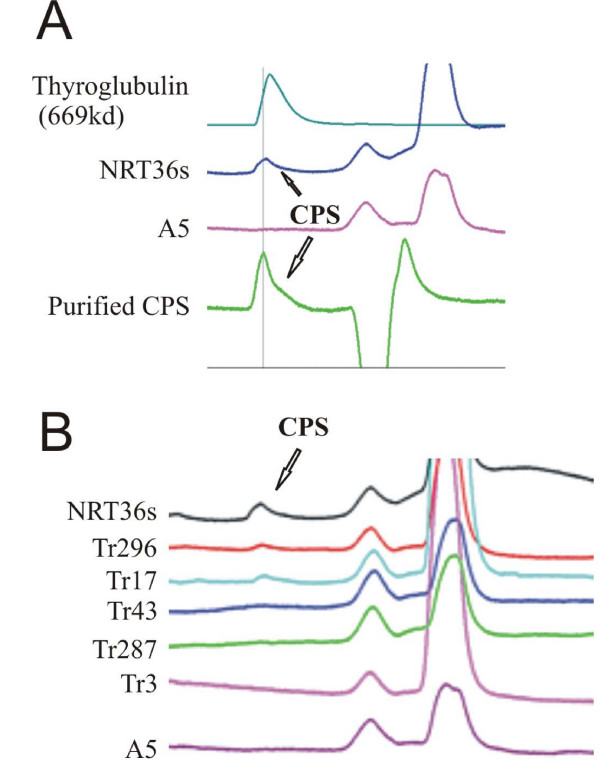
Size exclusion chromatography of the capsule prep. A). Capsule prep from control (NRT36S and A5) compared to purified CPS of NRT36S. The size was estimated by thyroglobulin. The arrow indicates the peak of the capsule at about 13.2 minutes retention time, which corresponds to about 670 k Dalton molecular weight. B). Capsule prep from mutants and control.